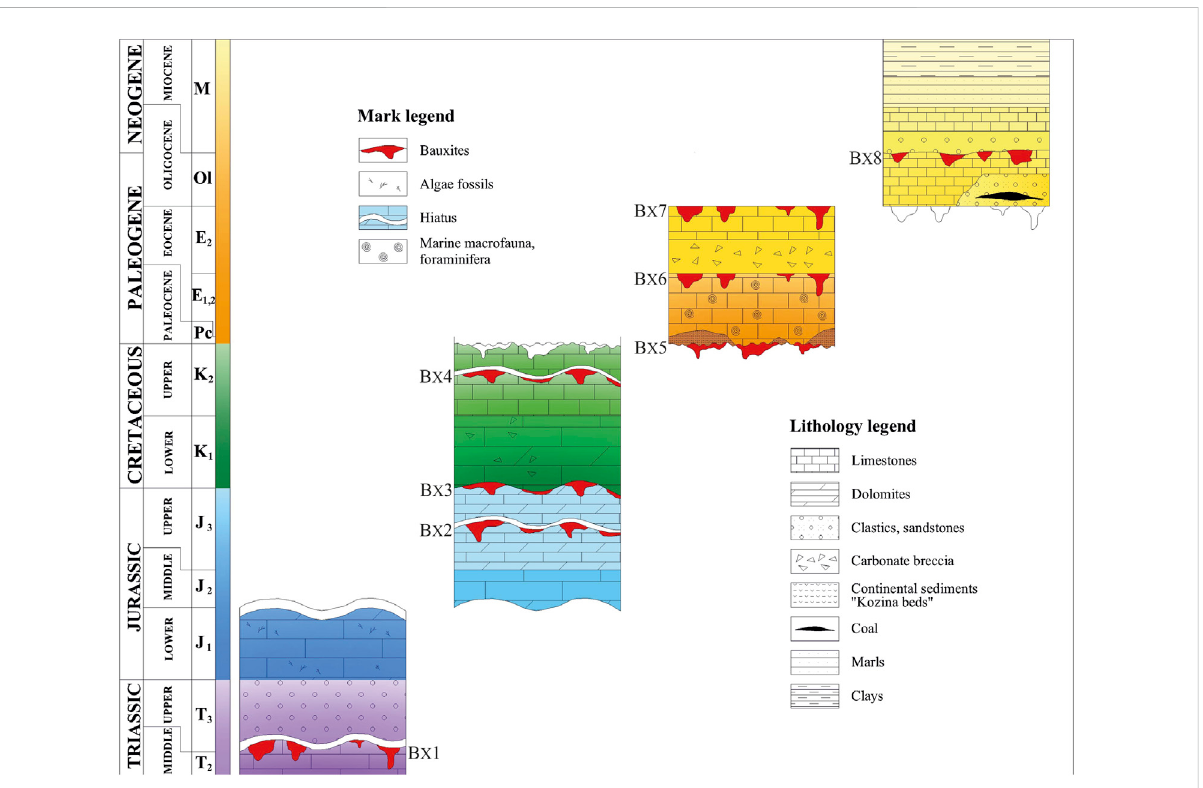
FIGURE 2 Stratigraphic position of bauxite-bearing horizons in the Croatian karst Dinarides: BX1 Upper Triassic, BX2 Upper Jurassic, BX3 Lower Cretaceous, BX4 Upper Cretaceous, BX5 Lower Paleogene (Paleocene), BX6 Middle Eocene, BX7 Upper Eocene, and BX8 Miocene.